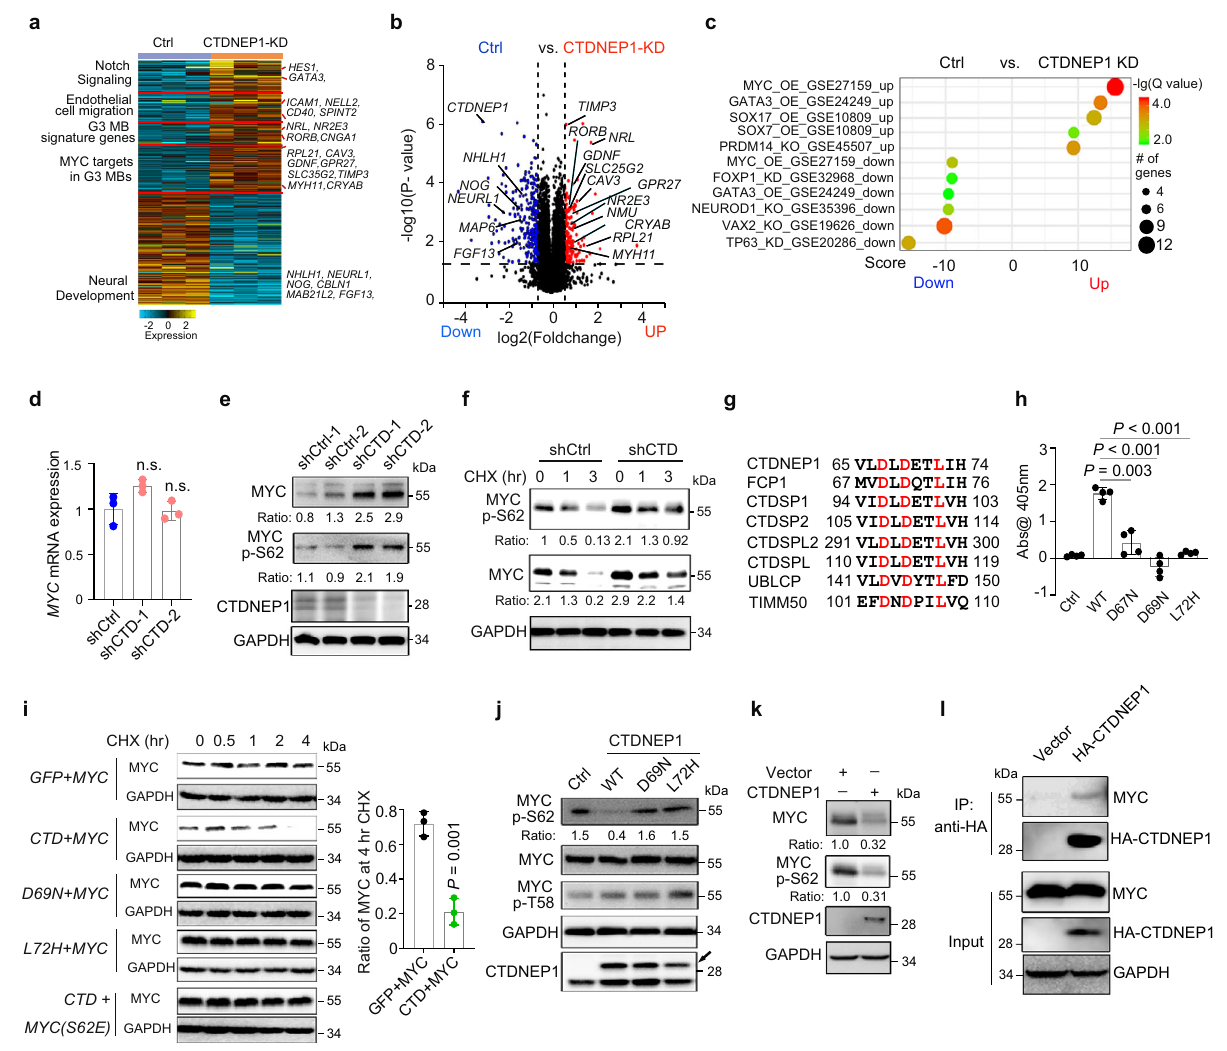
Fig. 3 | Loss of CTDNEP1 increases MYC stability and activity. a Heatmap of differentially expressed genes in D425 cells treated with shCtrl and shCTD. b Volcano plot of transcriptome pro fi les between control D425 cells and shCTDNEP1 (CTDNEP1-KD) treated cells. Red and blue dots represent genes sig- ni fi cantly upregulated and downregulated in cells depleted of CTDNEP1 ( p <0.05, false discovery rate [FDR]<0.1, two-sided Student ’ s t test for correction for mul- tiple hypotheses testing), respectively. c Correlations of upregulated genes in shCTDNEP1 D425 cells with MYC expression in G3 MBs. Benjamini-Hochberg method with correction for multiple hypothesis testing of signi fi cance. d qRT-PCR quanti fi cation of c-MYC mRNA in shCtrl and shCTD-treated D425 cells. n.s., not signi fi cant. e Representative immunoblots from 2 independent experiments for total MYC protein and p-S62-MYC in shCtrl and shCTD-treated D425 cells. f Representative immunoblots from 3 independent experiments for total MYC proteinand p-S62-MYC inshCtrland shCTD D425cells treatedwith cycloheximide (CHX, 10 μ g/ml) for 1 or 3h. g Conserved residues (red) in the catalytic motif of